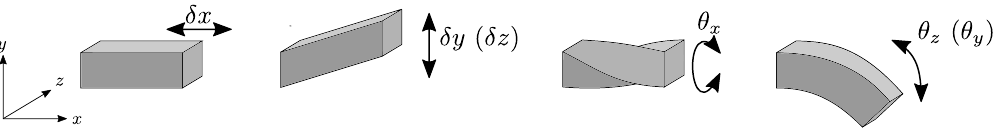
Figure 3. Four basic actuators kinematics can be define, corresponding to the six degrees of freedom of a surface when considering the other side fixed: three translations (elongation/compression δ x and shear δ y and δ z ) and three rotations (twisting θ x and bending θ y and θ z